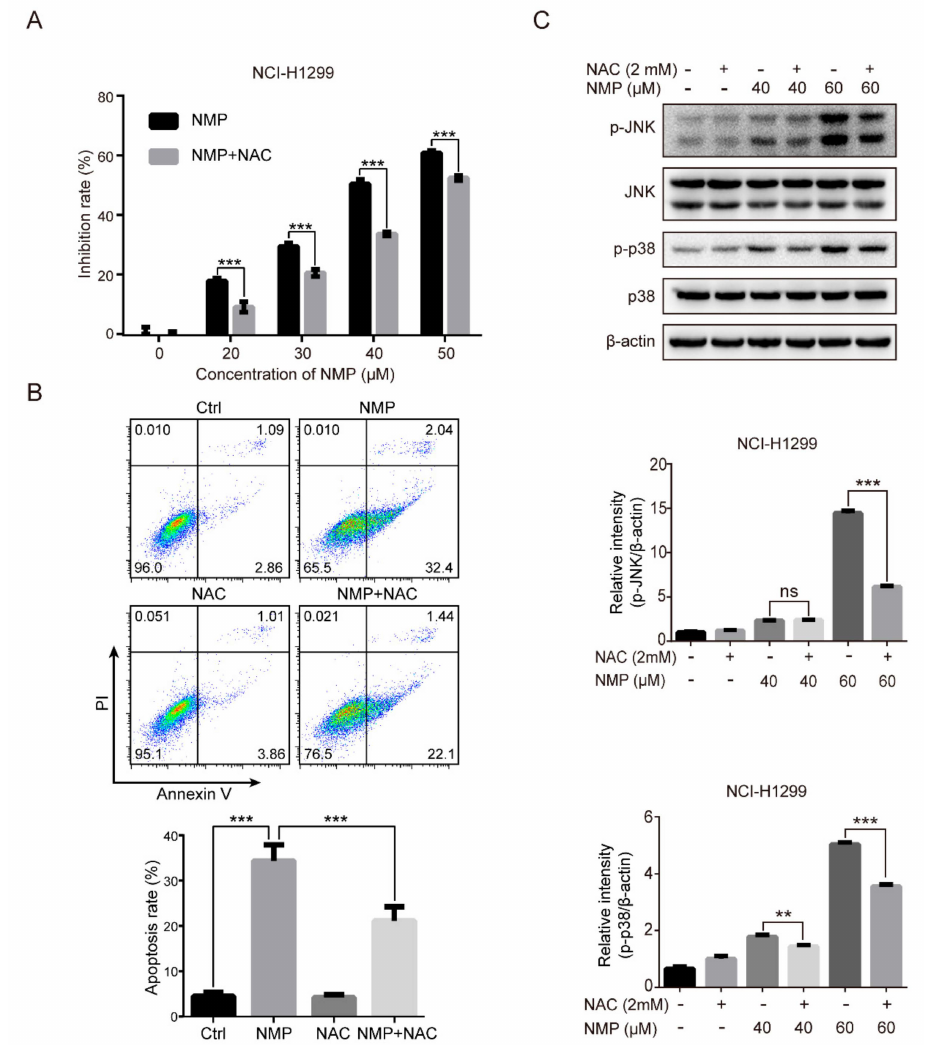
Figure 5. ROS clearance reversed JNK / p38 activation and attenuated NMP-induced apoptosis. ( A ) CCK-8 viability assay of NCI-H1299 cells treated with di ff erent concentrations of NMP with or without NAC (2 mM) for 24 h. ( B ) Flow cytometry analyses of the treated cells with Annexin V / PI labeling. ( C ) Western blot analysis for MAPK pathways of the treated cells. Error bars, means ± S.D. of three independent experiments; ** p < 0.01; *** p < 0.001, compared to the control